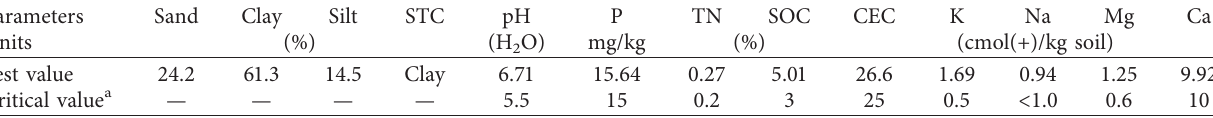
Table 2: Physical and chemical characteristics of the soil used for the greenhouse